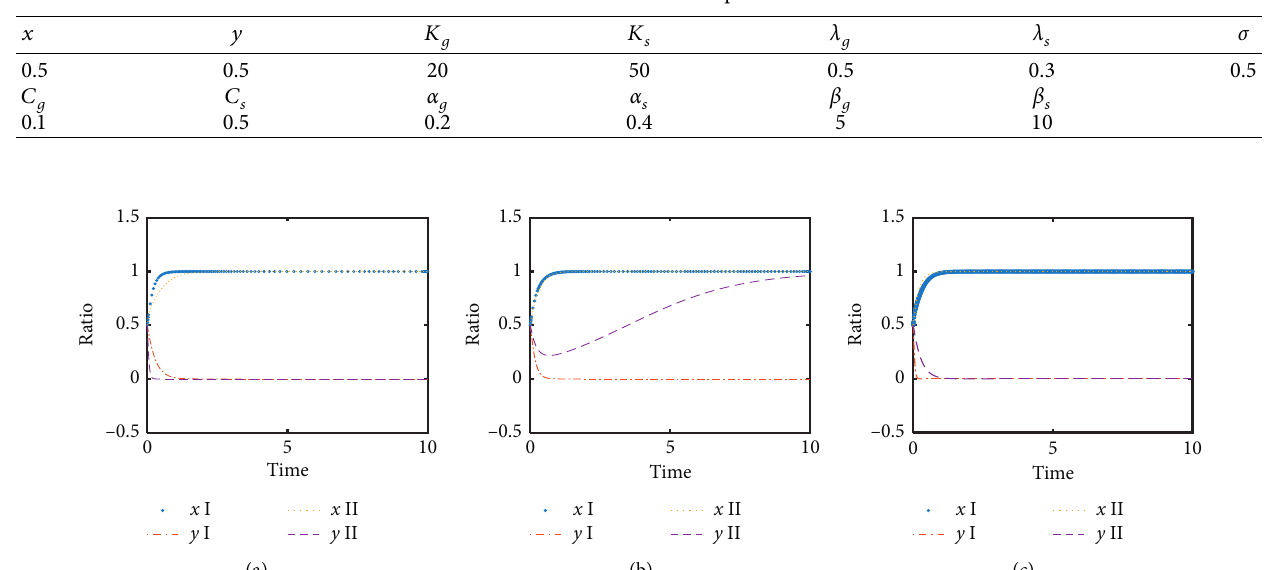
� 50 ,K � 100. (b) K � 50 ,K � 50. g s g s